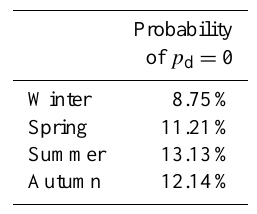
Table 1. Observed probability of p d = 0 for the storms in the dif- ferent seasons